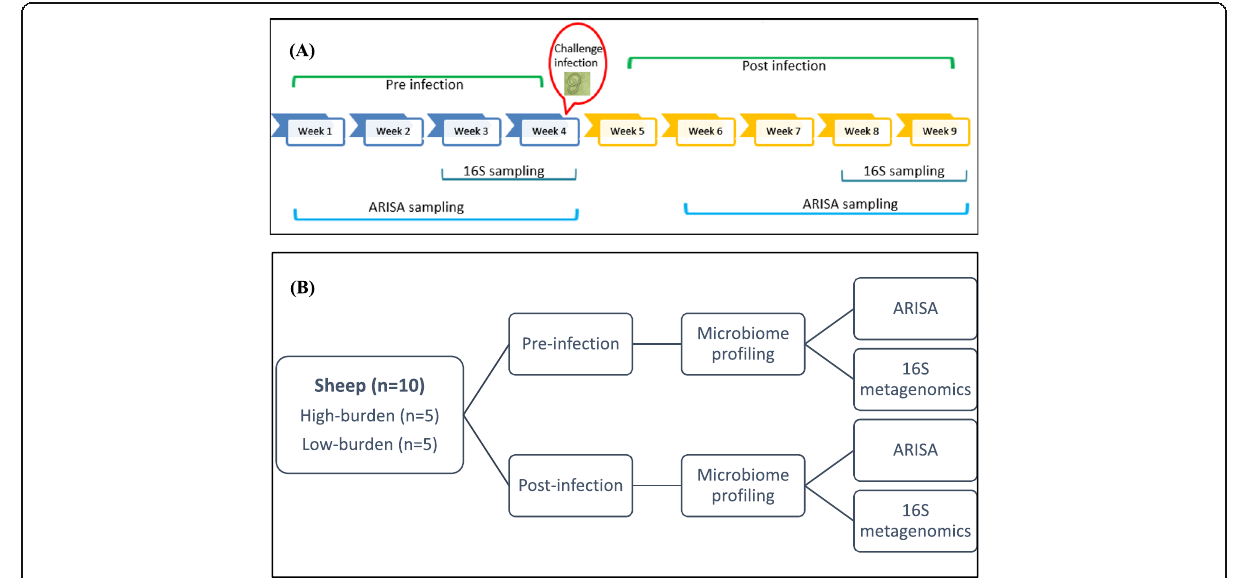
Fig. 8 Diagrammatic representation of experimental design. ( a ): Time course of sampling and experimental infection; ( b ): Analytical procedure for sheep before and after experimental infection with H.